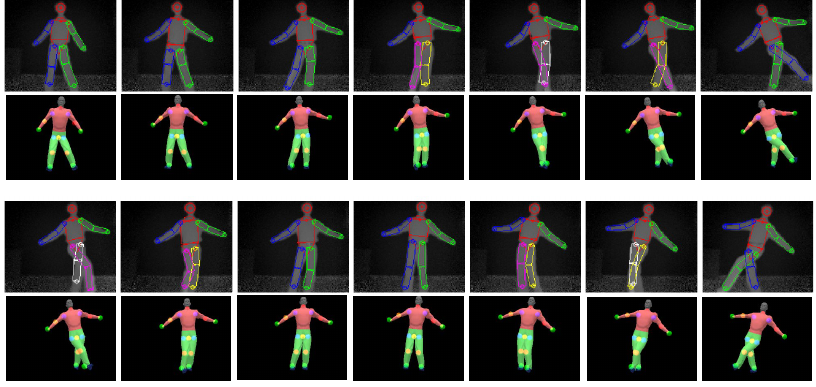
Figure 9. Whole body pose tracking with self occlusions during leg crossing. Rows 1 and 3: depth image sequence with the detected body parts. Rows 2 and 4: corresponding reconstructed pose.